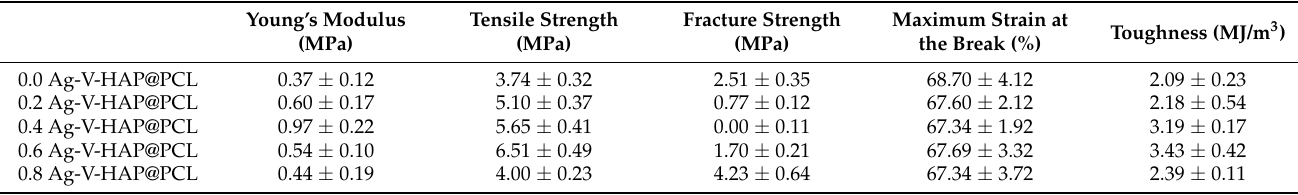
Table 3. The mechanical properties of Ag/V-HAP@PCL at different contents of Ag, including Young’s modulus, tensile strength (MPa), fracture toughness, fracture strength, and maximum strain before the break.